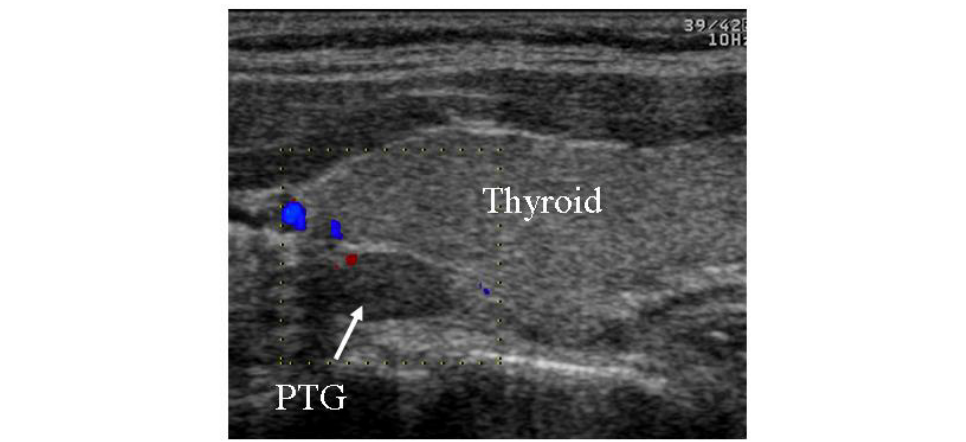
FIGURE 5. PTG without vascularity in 42-year-old woman, on dialysis treatment 5 years, PTH 166.1 pg/ml (longitudinal section, linear probe 13 MHz).